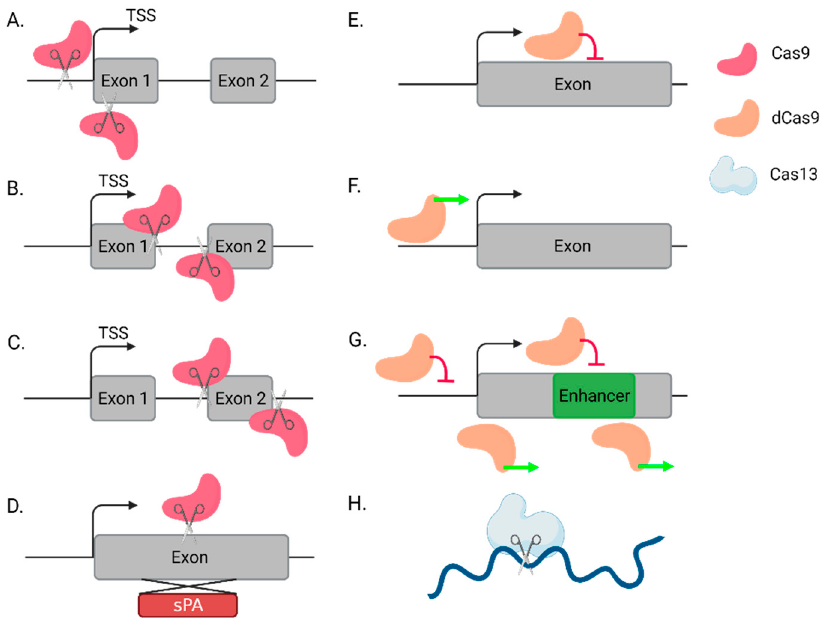
Figure 1. A schematic illustration of CRISPR-based approaches to study lncRNAs. ( A ) Transcription start site (TSS) deletion. ( B ) Mutations of splice sites. ( C ) Removal of an exon or a large genomic fragment. ( D ) Knock-in: insertion of a synthetic polyadenylation (spA) signal. ( E ) Knockdown by CRISPRi. ( F ) Gene overexpression by CRISPRa. ( G ) Tiling a genomic locus using CRISPR-ko/CRISPRi/CRISPRa to identify enhancers, which in many cases can overlap or affect lncRNAs. ( H ) Targeting an RNA transcript by Cas13. (Created with BioRender.com (accessed on 12/12/2021)).